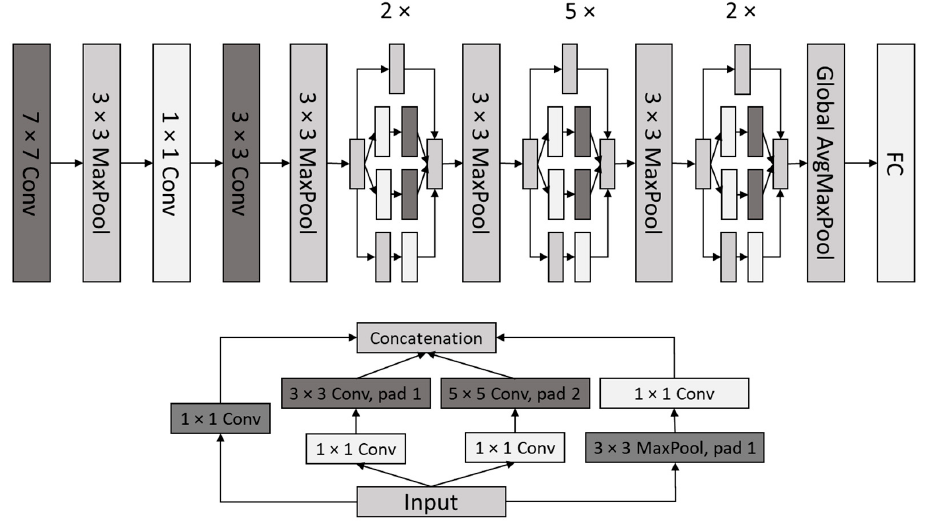
Figure 3. The GoogleNet architecture and Structure of the Inception block.